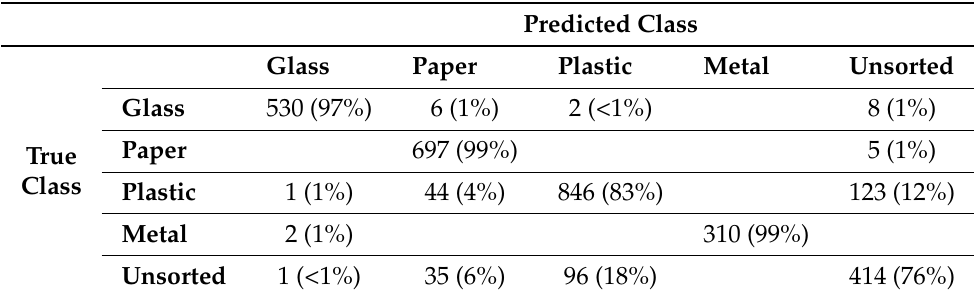
Table 3. Test confusion matrix obtained for sensor-based